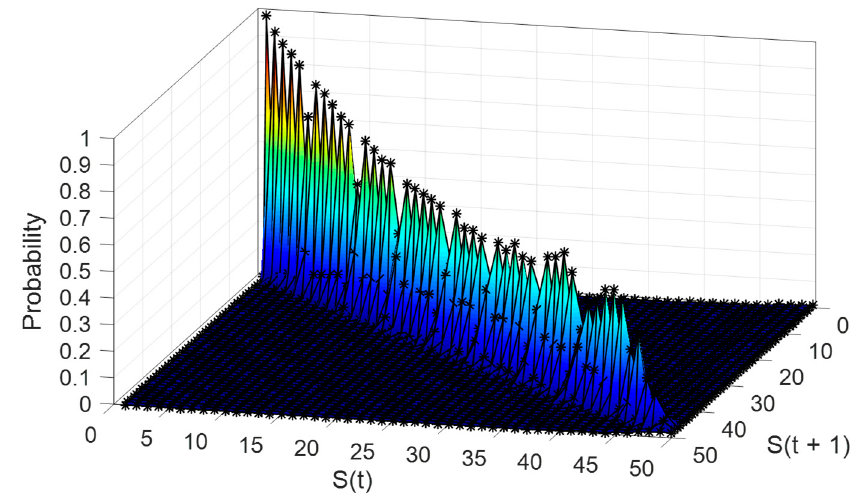
Figure 5. Markov state transition matrix.